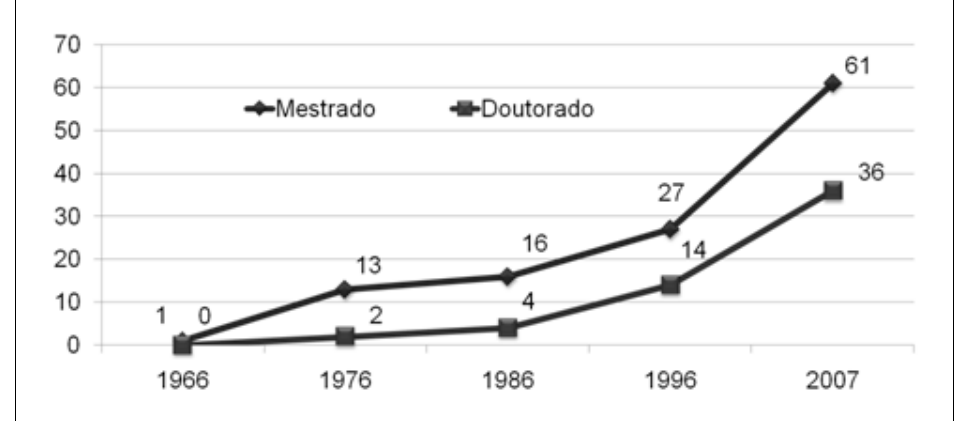
Figura 1. Crescimento do Sistema (total) – Psicologia (retirada de Yamamoto & Tourinho,